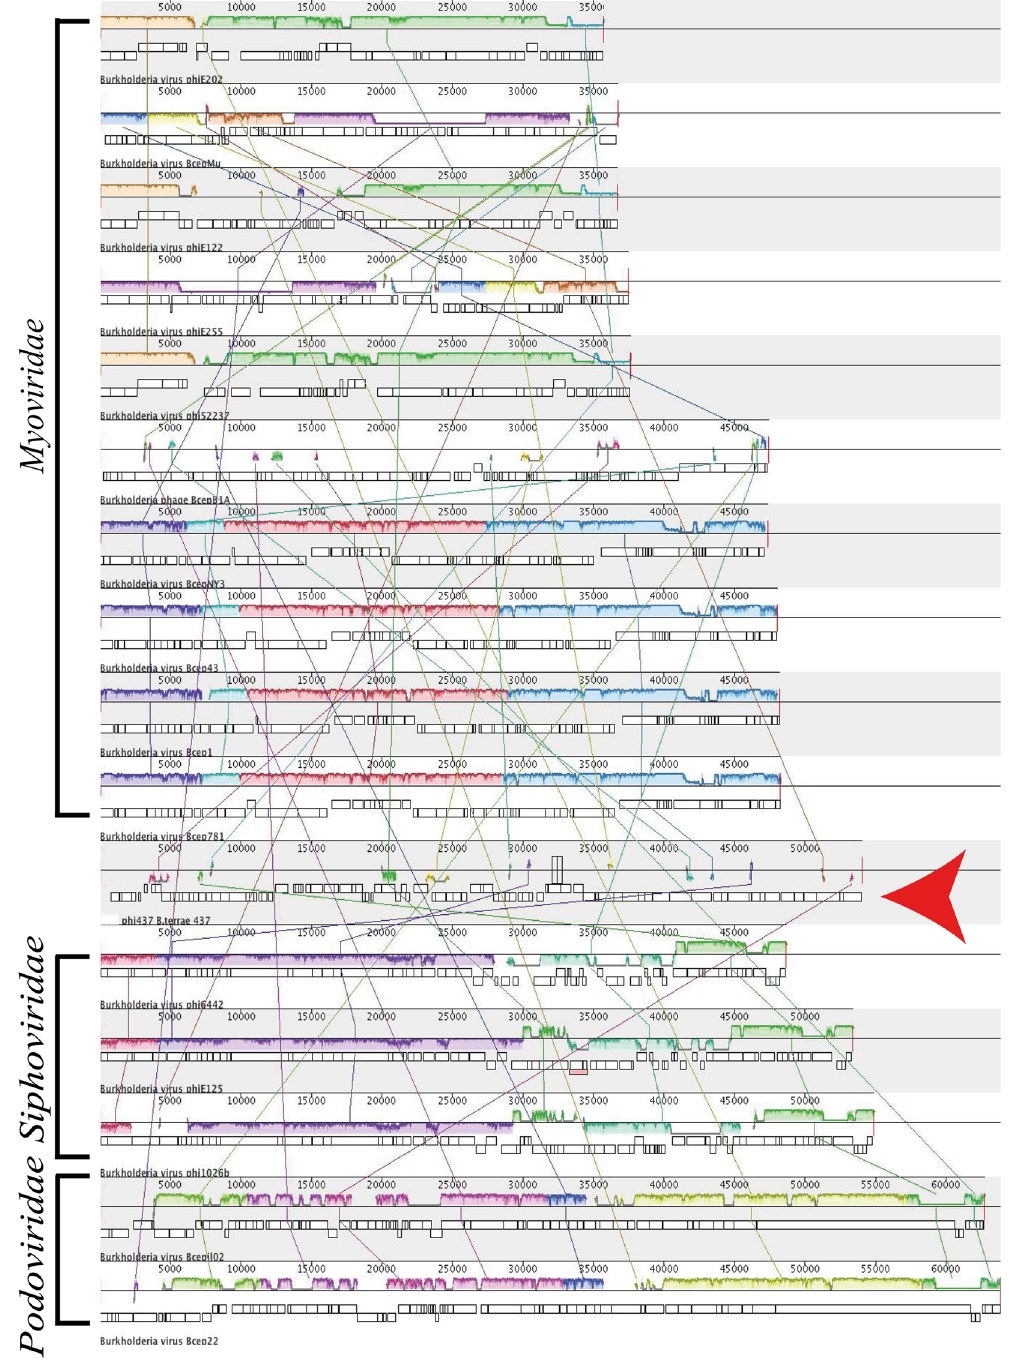
Figure 3. The Multiple genome alignment of Burkholderia phages. Genome were compare using progressiveMauve software, the genome homologous indicates by the local coliner blocks (LCB) and connected with lines. The analysis included known Burkholderia phages from Myoviridae , Siphoviridae and Podoviridae . The ɸ 437 is indicated by red